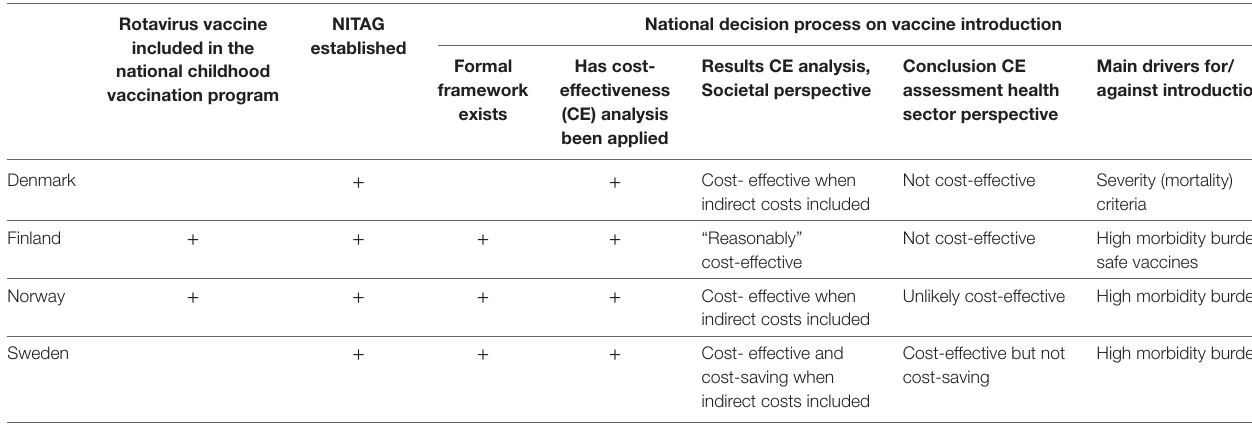
TABle 2 | Organization and outcomes of national decision processes on rotavirus vaccine introduction in Scandinavian countries (Denmark, Finland, Norway, and Sweden). rotavirus vaccine included in the national childhood vaccination